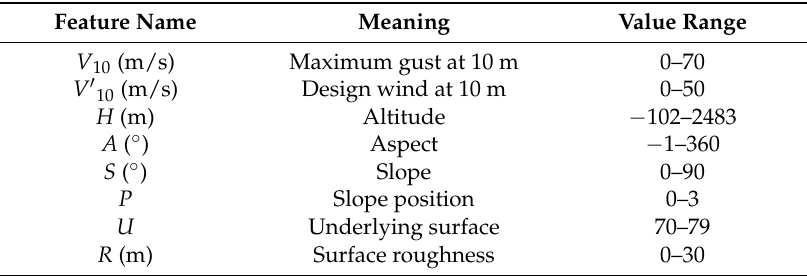
Table 2. Feature interpretation